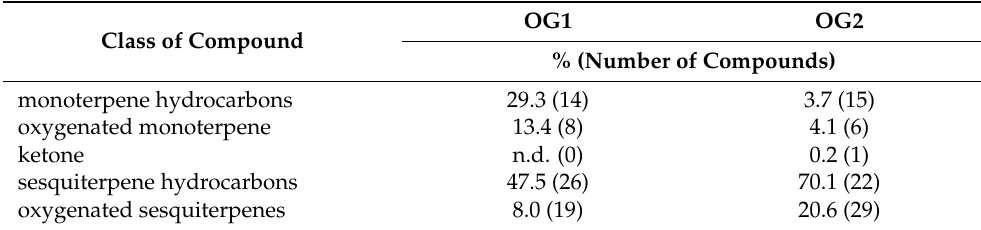
Table 2. Percentage composition and number of terpene hydrocarbons, oxygenated terpenes, and nonterpenoid